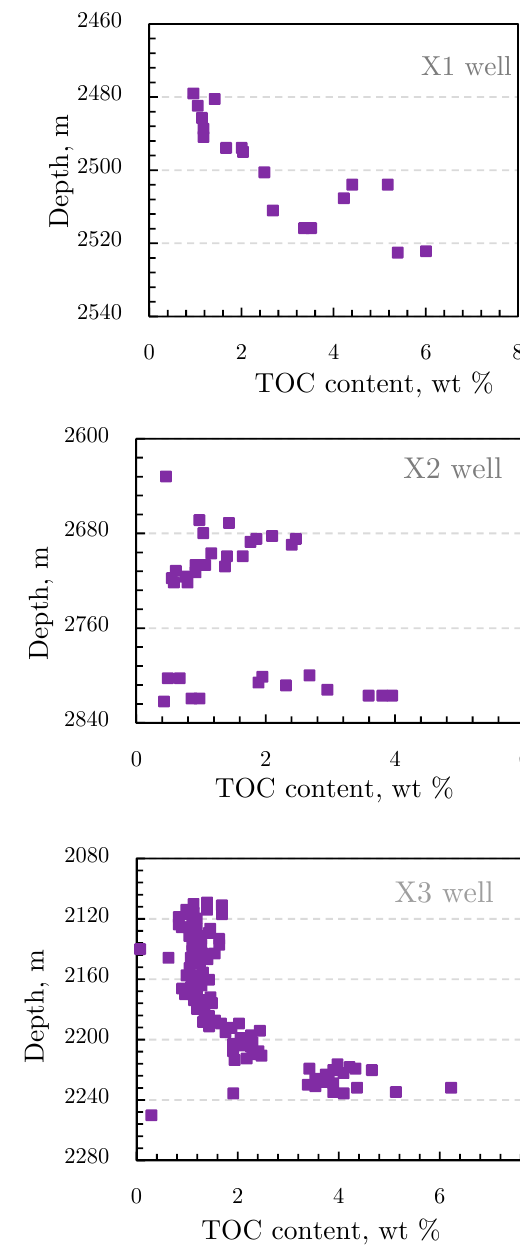
Figure 7. The frequency distribution histogram of TOC content as well as its relationship with depth in the Longmaxi Formation.